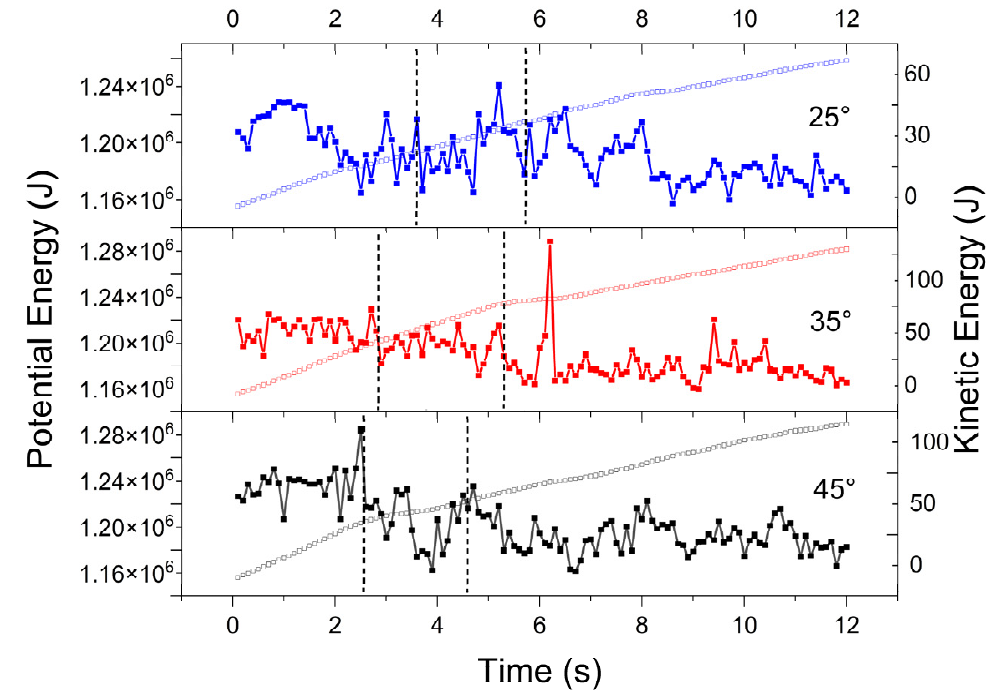
( b ) Figure 14. Characteristic evolution curve of contact force chain: ( a ) the proportion of strong chains at different internal friction angles; ( b ) the coordination number proportion at different internal fric- tion angles. When the slip planes 1 and 3 are formed, the dislocation and instability of the dis- placement region and the stability region exist in the collapse body, leading to the reduc- tion in the contact of the collapse bodies on both sides of the slip plane and the interrup- tion and reconstruction of the strong force chain dominated by the stress arch. The failure